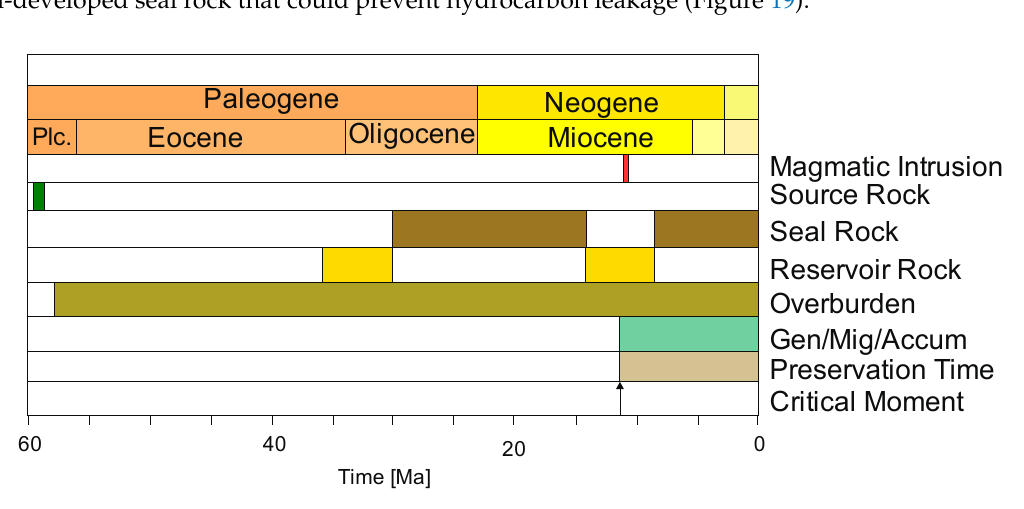
Figure 19. Petroleum system chart for the study area.